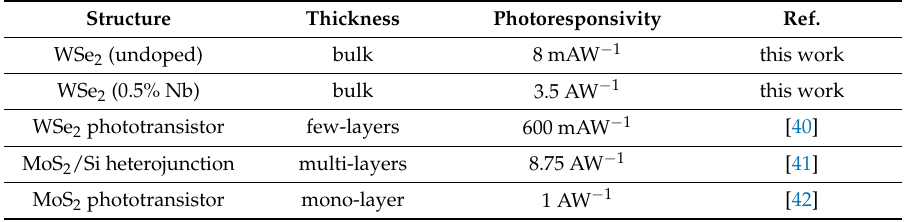
Figure 1. Experimental piezoreflectance (PzR) spectra of undoped and 0.5% Nb-doped WSe 2 -layered crystals at 300 K. The solid curves are the fits to the first derivative Lorentzian line shape. The obtained near band edge excitonic transitions A and B are indicated by arrows. Table 1. Comparison of photoresponsivity for the WSe 2 and MoS 2 based photodetection